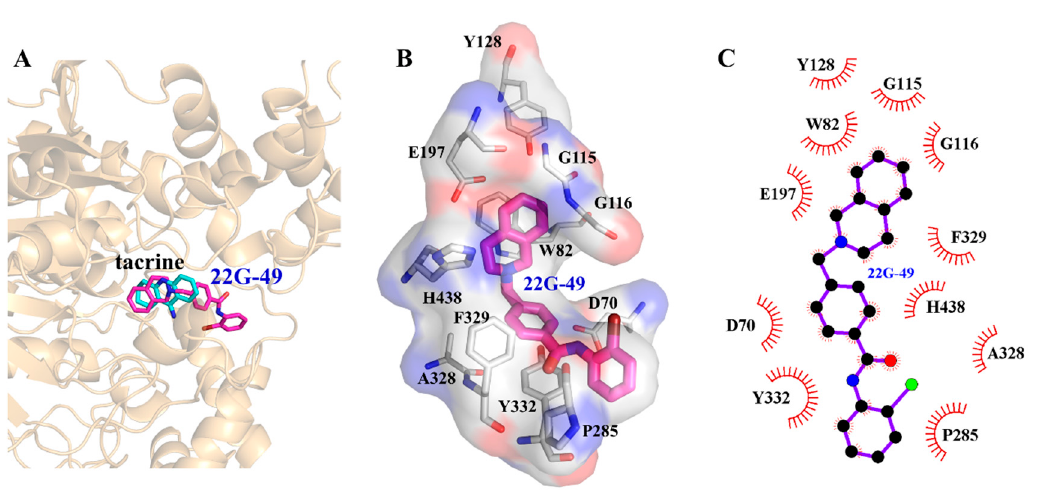
Table 4. The binding free energy calculated by MM-PBSA method. ∆ G gas represents the binding free energy in vacuum and ∆ G solv represents the solvation free energy changes. ∆ G = ∆ G gas + ∆ G solv . The data were shown in kcal/mol.